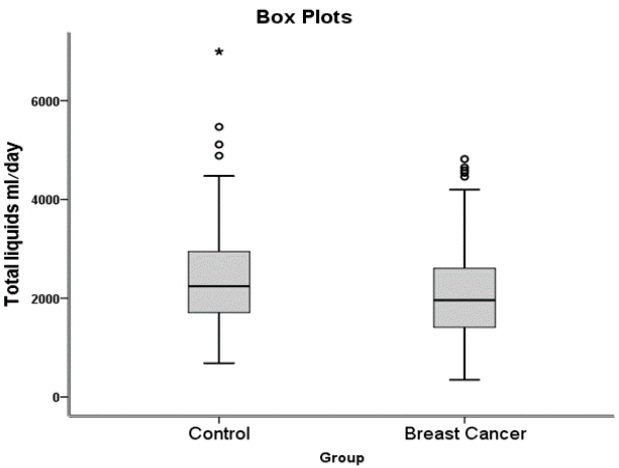
Figure 2. Liquids consumption (mL/day).